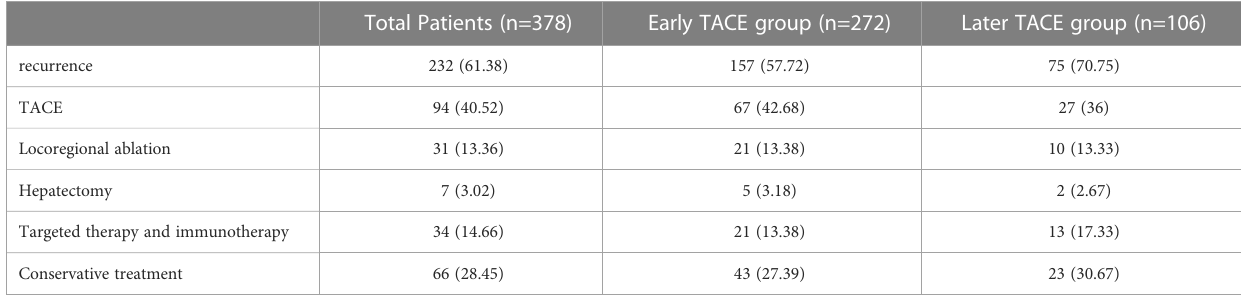
TABLE 4 The subsequent antitumor therapies after